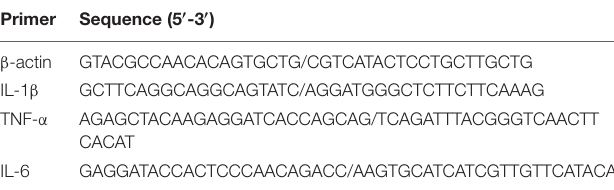
TABLE 2 | Primers used in this study.